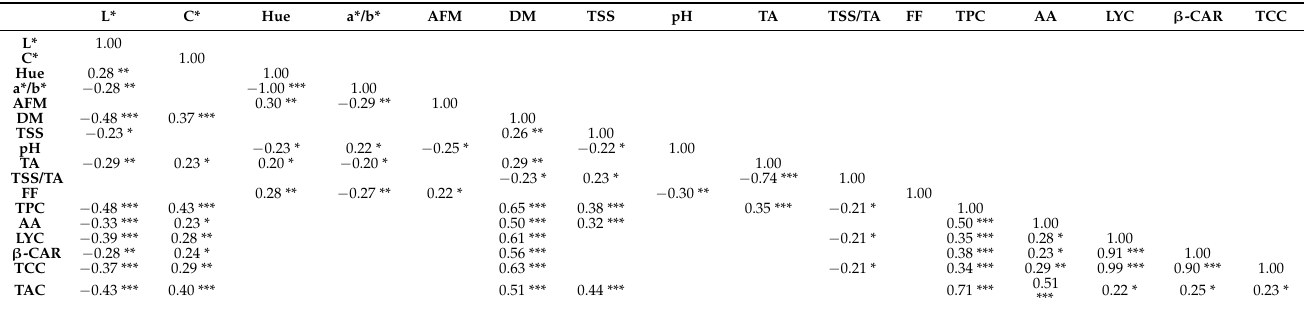
Table 13. Correlation coefficients between average visual (luminance: L*, chroma: C*, hue, a*/b*, fruit mass: AFM), flavor (dry mass: DM, total soluble solids: TSS, titratable acidity: TA, flesh firmness: FF) and functional quality traits (total phenolic content: TPC, ascorbic acid: AA, lycopene: LYC, beta carotene: β -CAR, total carotenoid content: TCC, total antioxidant capacity: TAC) of tomato fruit over three harvest dates. The fruit was obtained from self-rooted ‘Beef Bang F1’, ‘Beef Bang F1’ grafted onto ‘Defensor’, trained in single or double stem and grown hydroponically in four substrates (rockwool slabs, perlite in sacks, pumice in sacks and pumice in pots) in a